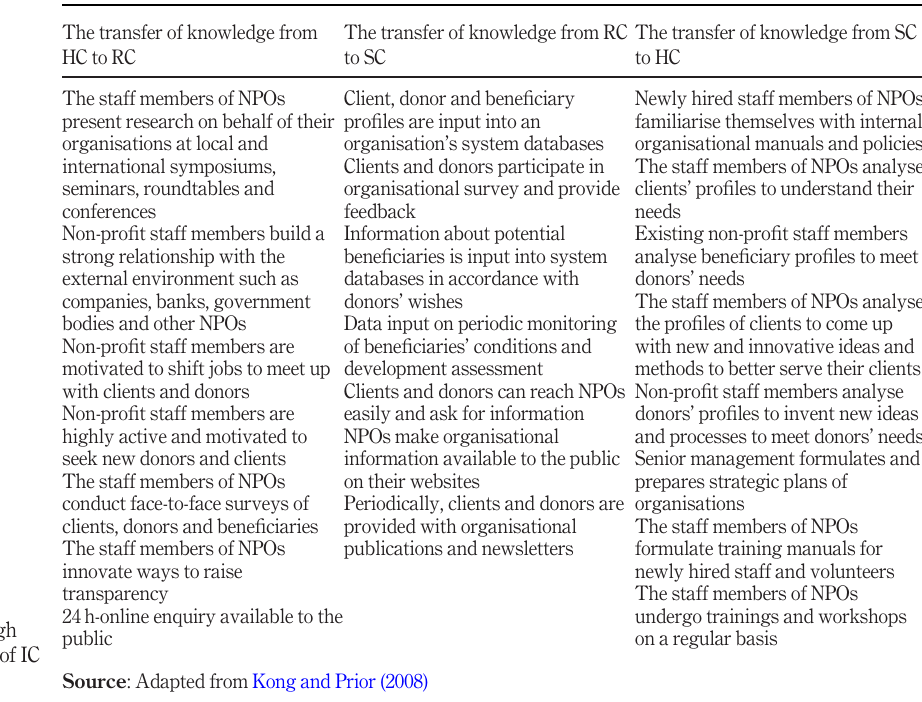
Figure 1. Conceptual framework of IC and competitive advantage in NPOs